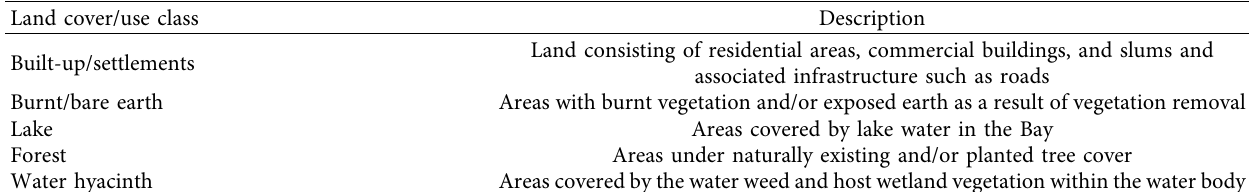
Table 1: Te land cover/use types’ classifcation system used for the Murchison Bay area. Land cover/use class